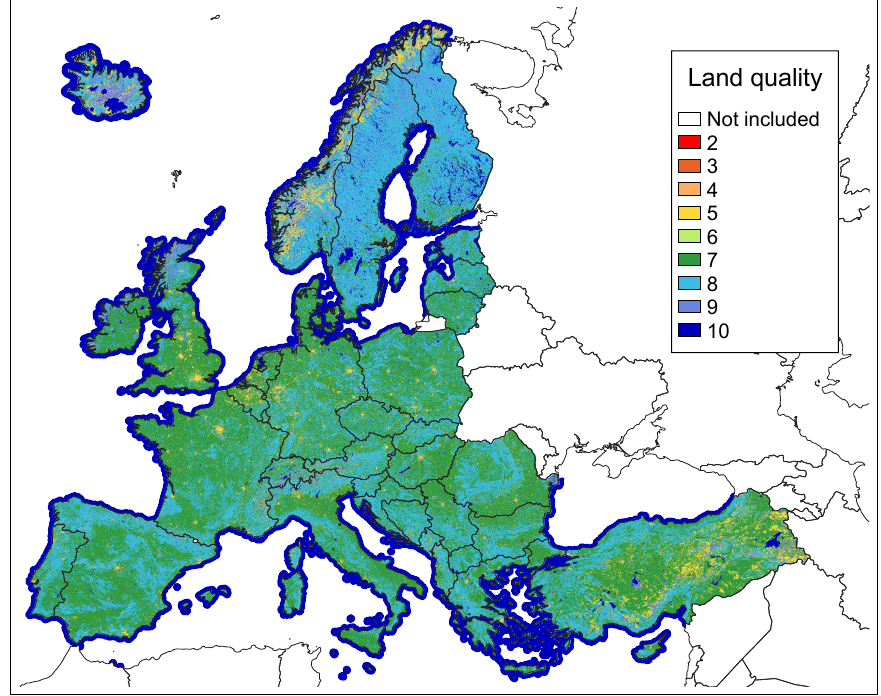
Figure 4. Geographical coverage of land quality assessment in Europe. Own illustration based on